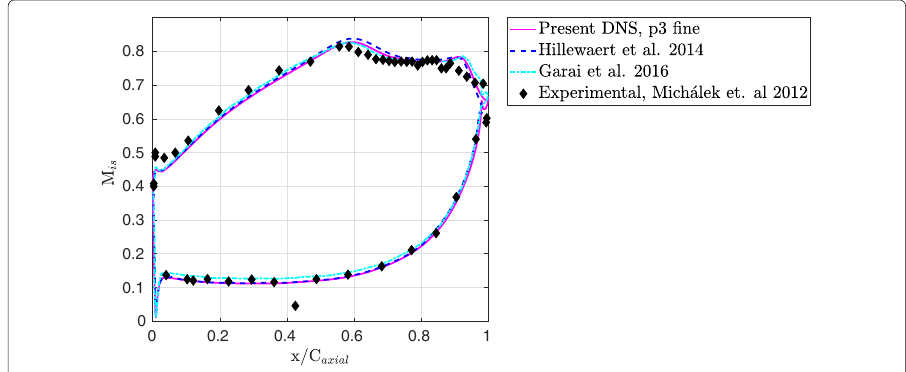
Fig. 9 Comparison of the time- and spanwise-averaged isentropic Mach number M is with reference data